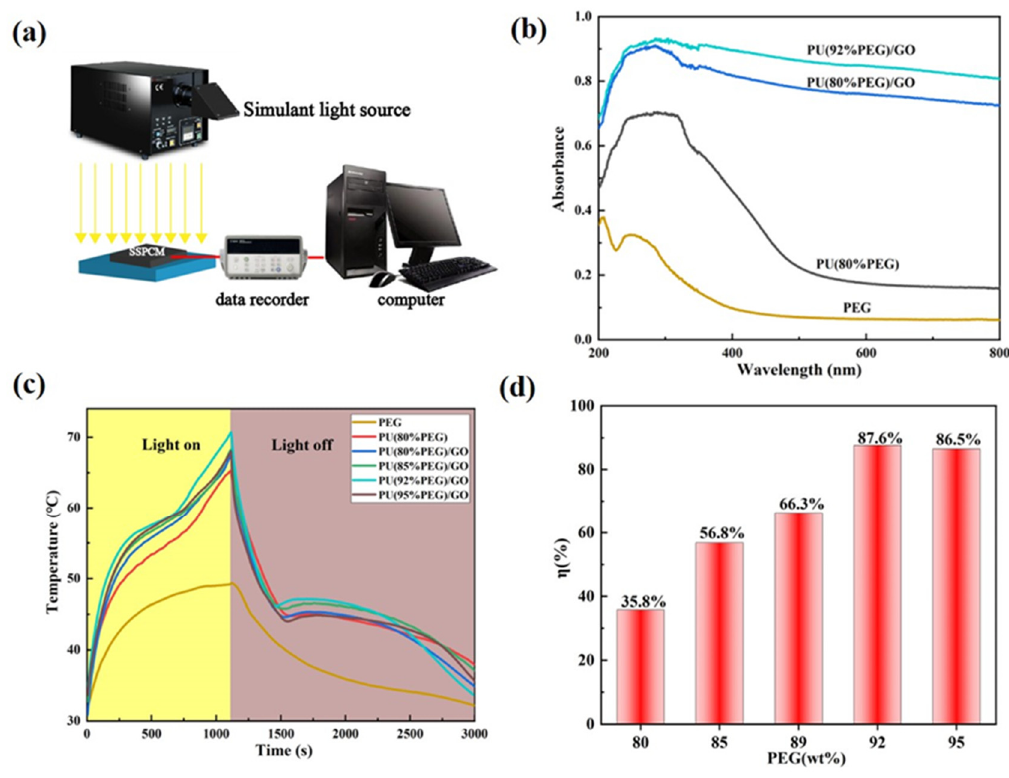
Figure 8. ( a ) Experimental diagram of photo–thermal energy conversion and storage test system; ( b ) absorption spectrum of PEG, PU and PU/GO; ( c ) temperature–time curves of PU/GO under simulated solar radiation at 100 mW/cm 2 ; ( d ) photo–thermal conversion efficiency for PU/GO doped with different contents of PEG.